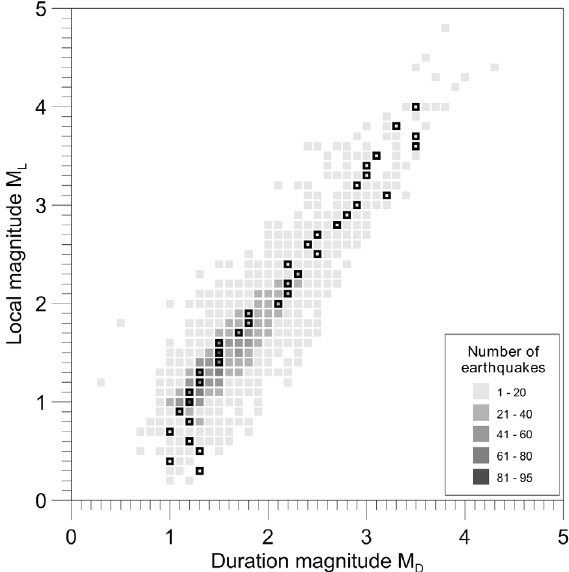
vs. M values of the earthquakes occurring at D L -M bins. Black squares indicate the M D L